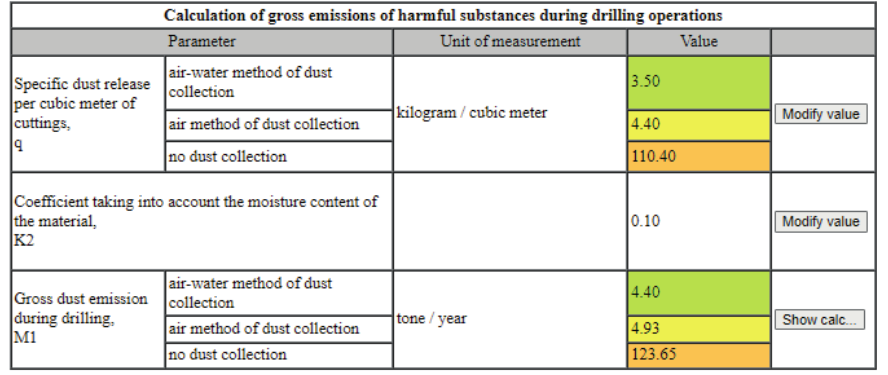
Fig. 2. Calculation of gross emissions of harmful substances during drilling operations